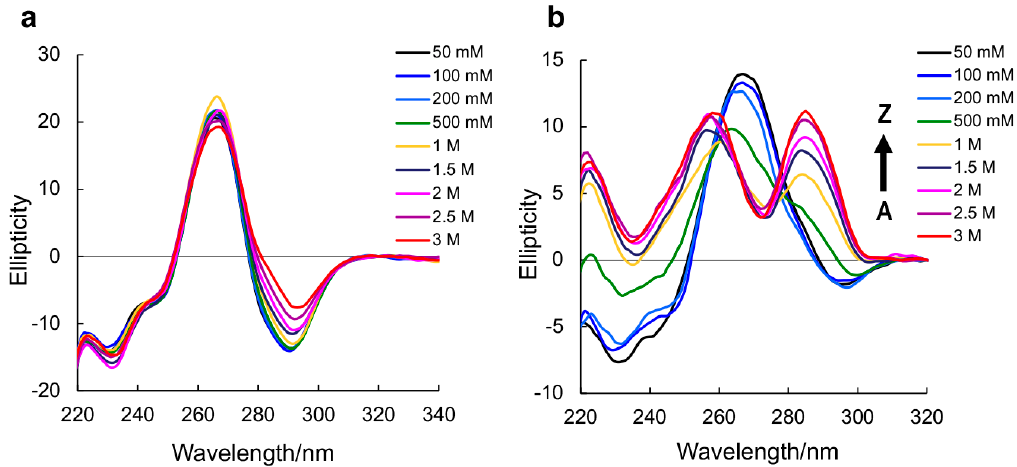
Figure 1. CD spectra of native RNA r(CGCGCG) 2 ( a ) and m 8 Gm-contained r(CGC[m 8 Gm]CG) 2 ( b ) (0.15 mM base concentration) at 10 °C with various NaClO 4 concentrations in 5 mM sodium phosphate buffer (pH 7.0).